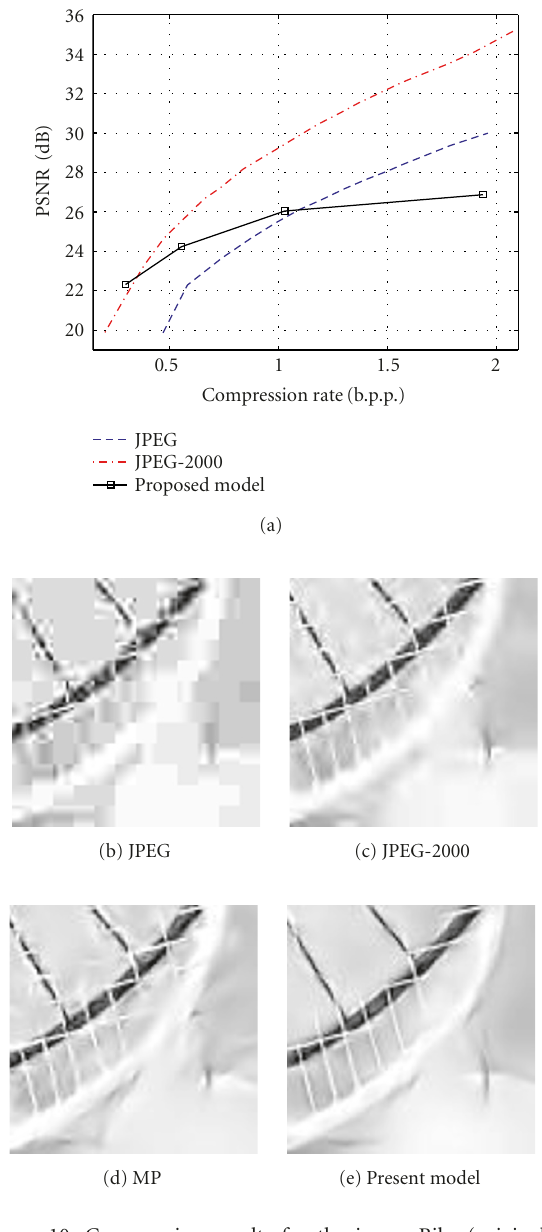
Figure 10: Compression results for the image Bike (original in Figure 9). (a) Evolution of the PSNR for di ff erent compression rates. The proposed method can o ff er a reconstruction competitive with the compression standards at very high compression rates. (b), (c), (d), (e) Compression results at 0 . 56 bpp, respectively, for JPEG, JPEG-2000, MP, and the proposed